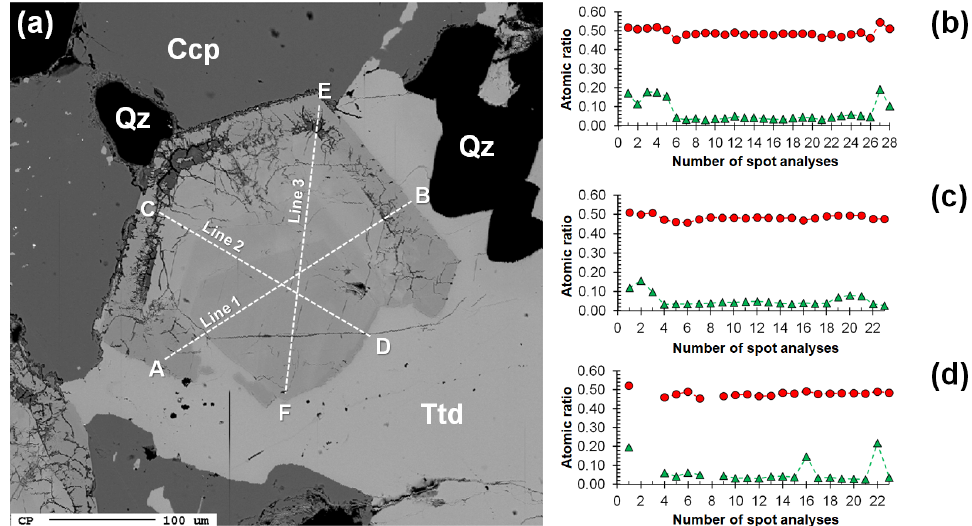
Figure 3. (a) Backscattered electron image of a zoned crystal of gersdorffite (see Fig. 2c) associated with chalcopyrite (Ccp), tetrahedrite- (Fe) (Ttd), and quartz (Qz). Dashed lines A–B, C–D, and E–F represent the transects where spot analyses were performed using a step of 10µm. Atomic ratios As / (S + As + Sb + Bi) and Fe / (Fe + Co + Ni) along the lines A–B (b) , C–D (c) , and E–F (d) are shown as red circles and green triangles, respectively. Omitted points in (d) correspond to weathering products along the E–F